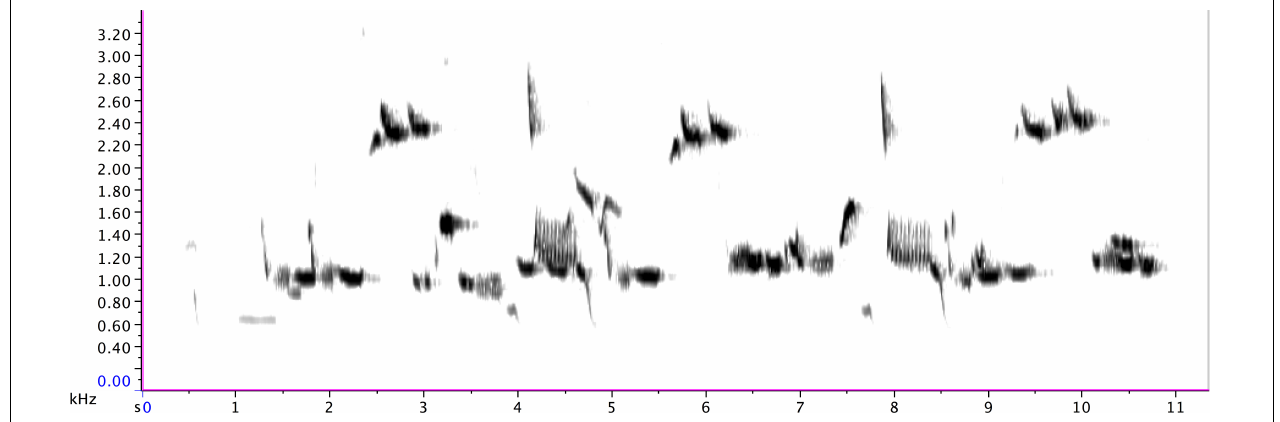
FIGURE 3 | An extended group phrase sung by a pied butcherbird family at Maleny on 25 March 2013 (at 11:51 of Supplementary Audio 2 ).